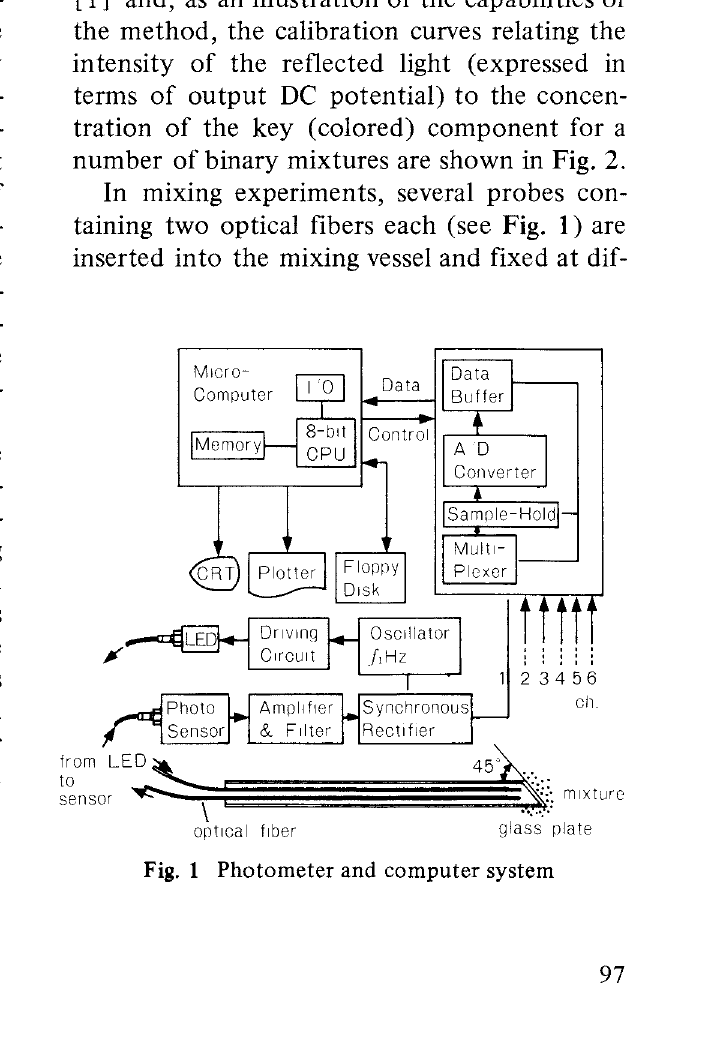
Fig. 1 Photometer and computer